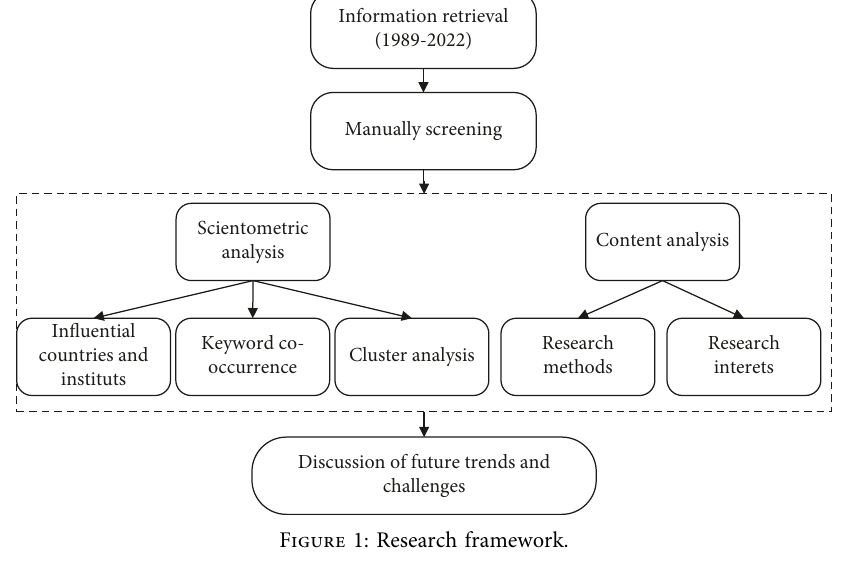
Figure 1: Research framework.